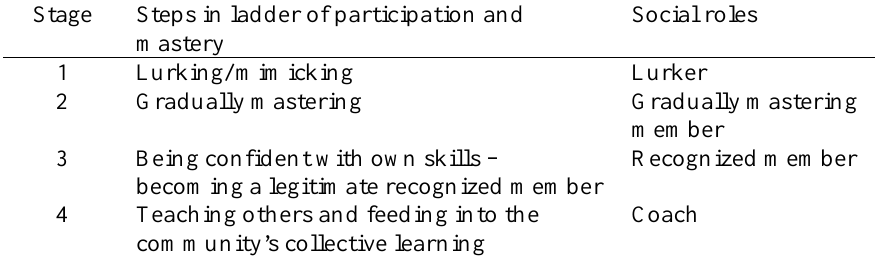
Social Roles Based on the Ladder of Participation and